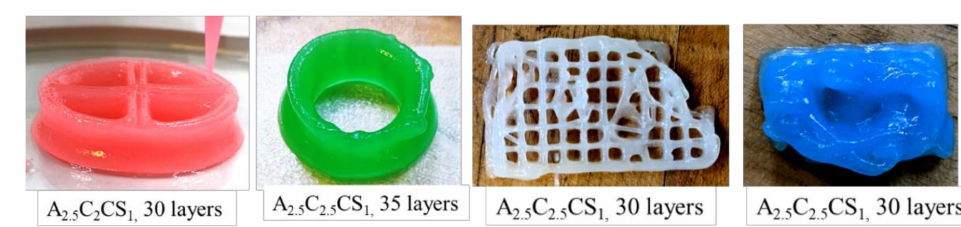
Figure 15. Scaffolds printed with the compositions of A 2.5 C 2.5 CS 1 and A 2.5 C 2 CS 1 . All scaffolds preserved the external and internal geometric fidelity and showed minimal discrepancy with respect to the digital model we used for fabrication.